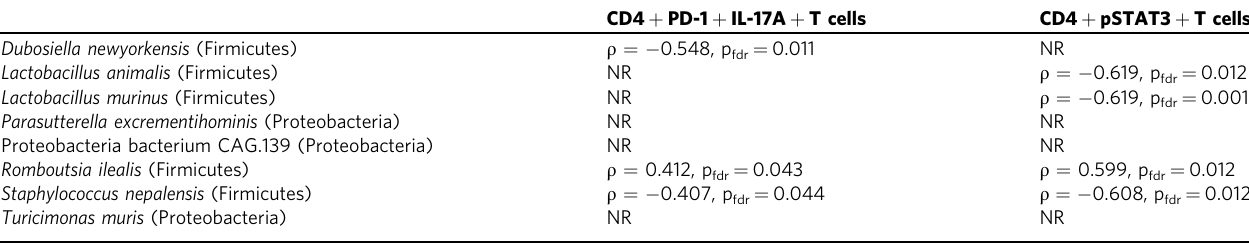
Table 1 Spearman correlation associations between individual taxa abundances and immunological